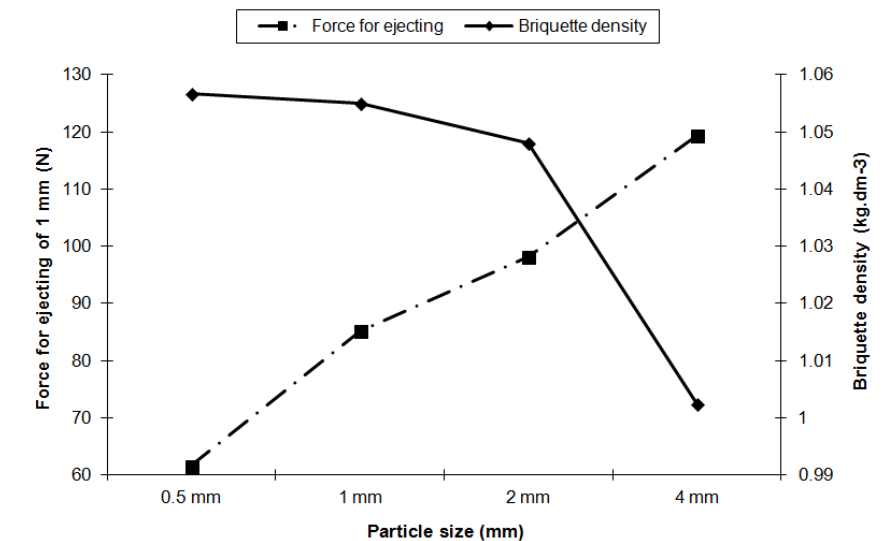
Figure 14. Cumulative interdependence—force for ejecting briquette, briquette density, and particle size ( w r = 8%; T = 25 °C) at 254 MPa.